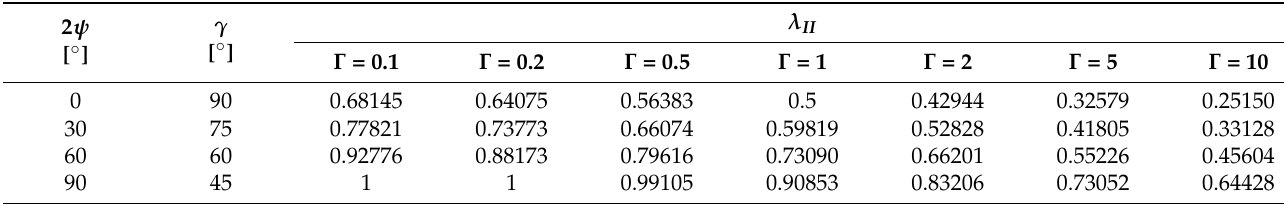
Table 2. The eigenvalues λ II (Mode II).